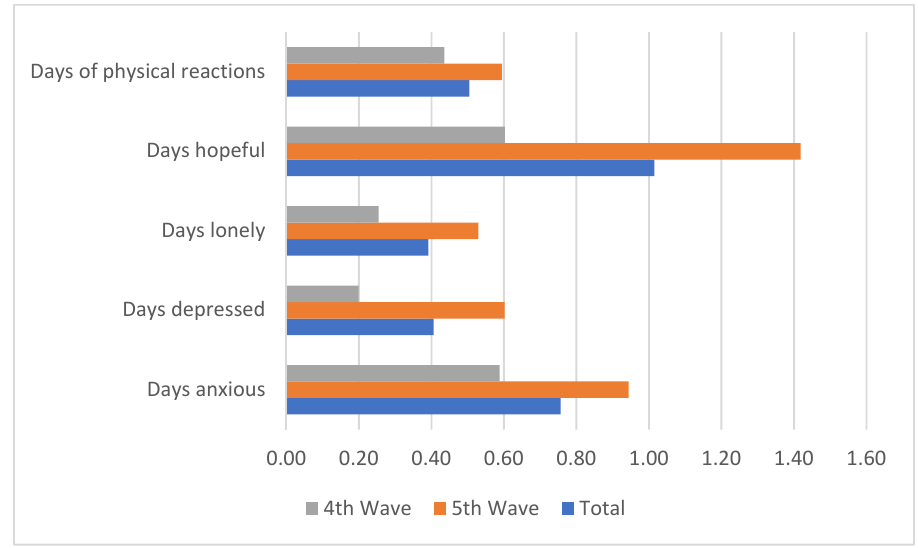
Figure 3. Average number of days with specific experience of mental health problems.